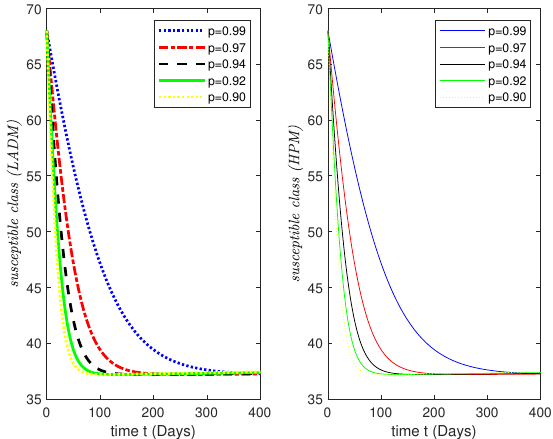
Figure 7. Comparison of the approximate solution for X ( t ) class of the suggested model at different arbitrary fractional orders by LADM and